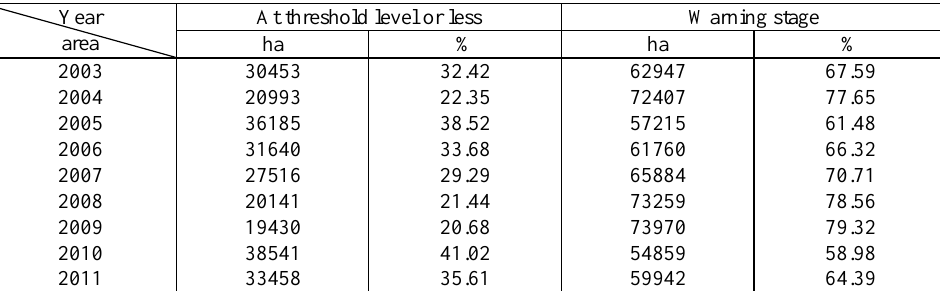
Table 3. The extent of areas under warning based on EC during 2003-2011